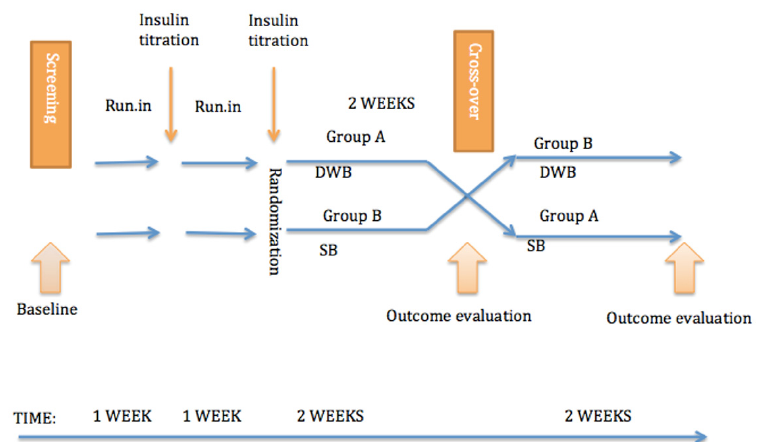
Figure 1. The structure of the study. DWB (dual-wave bolus); SB (Standard